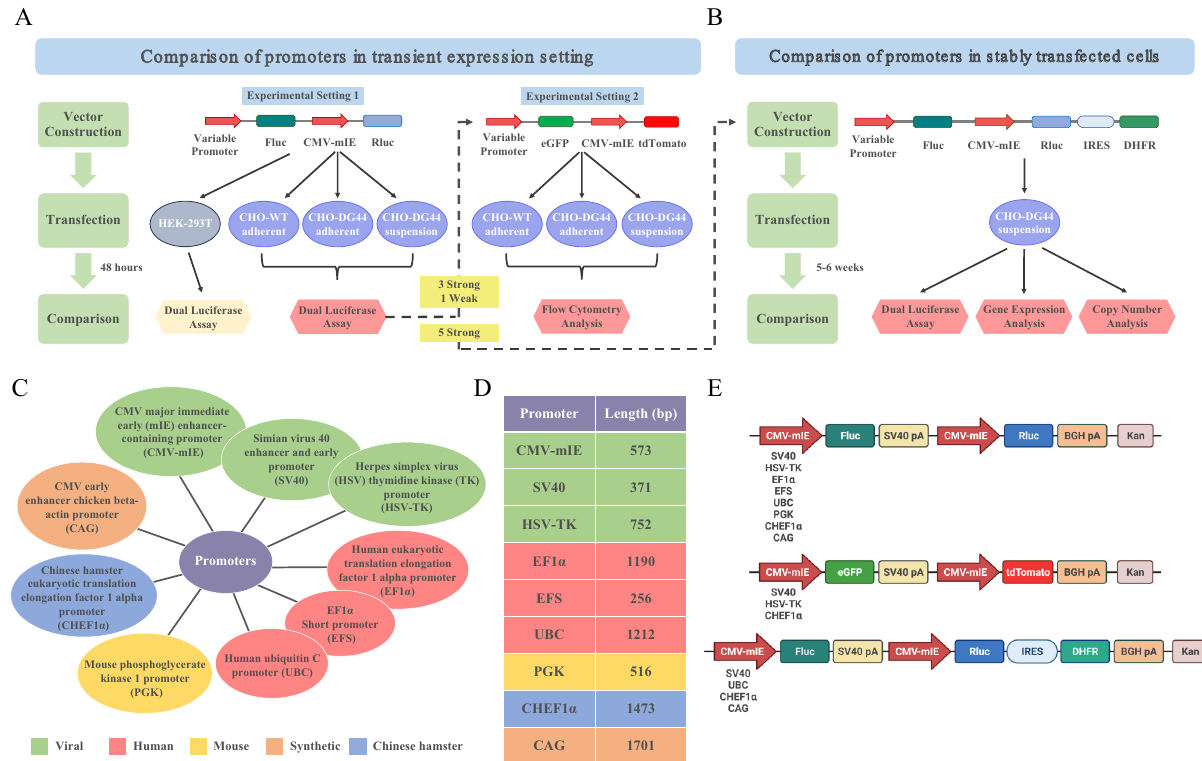
Figure 1. Experimental workflow of the study, promoter characteristics and vector designs. ( A , B ) Schematic representation of the workflow: Promoter strengths in the transient expression context were quantified using dual luciferase assay and flow cytometry analysis. ( A ) All nine promoters were compared based on luciferase activity in CHO cell variants and HEK-293T cells (Experimental setting 1). To corroborate the dual luciferase reporter findings, one weak and three relatively strong promoters were cloned into the dual fluorescence reporter system and further investigated by flow cytometry analysis (Experimental setting 2). ( B ) The activity of five relatively strong promoters selected and prioritized from ( A ) was evaluated in stable transfectants of CHO-DG44 suspension cells by dual luciferase assay. Further experiments were performed to analyze the expression of Fluc and Rluc genes, as well as the copy number of Rluc and DHFR genes. ( C ) The list of well- known constitutive promoters tested herein. Color codes represent the origin of promoters. ( D ) The table depicts promoter lengths. ( E ) Representative vector maps of all-in-one reporter systems. In the dual luciferase reporter system, the variable promoter (CMV-mIE) was replaced by SV40, HSV-TK, EF1α, EFS, UBC, PGK, CHEF1α and CAG promoters. In the dual fluorescent reporter system, the variable CMV-mIE was replaced by SV40, HSV-TK and CHEF1α promoters. For stable expression analysis, the constructs with CMV-mIE, SV40, UBC, CHEF1α and CAG promoters were engineered to coexpress Rluc and DHFR genes separated by an IRES sequence, creating a bicistronic expression cassette. The schematics in ( E ) are created with